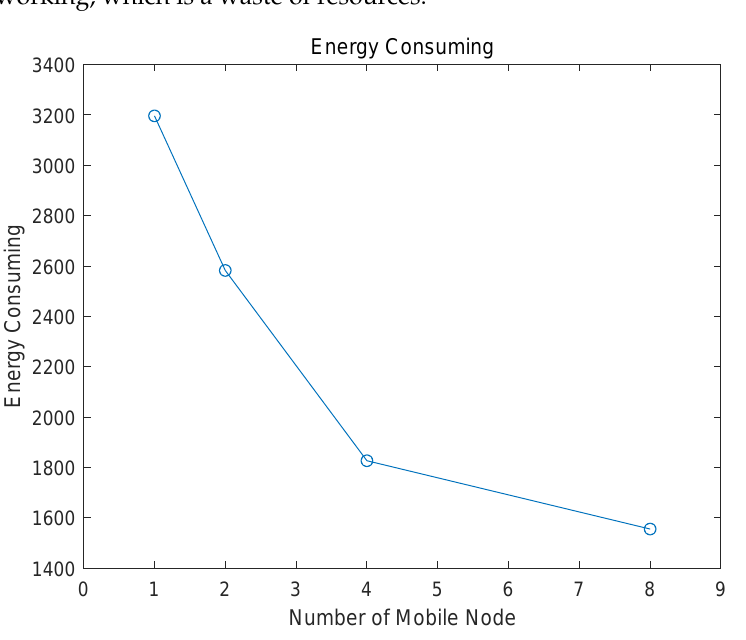
Figure 11. Trend of energy